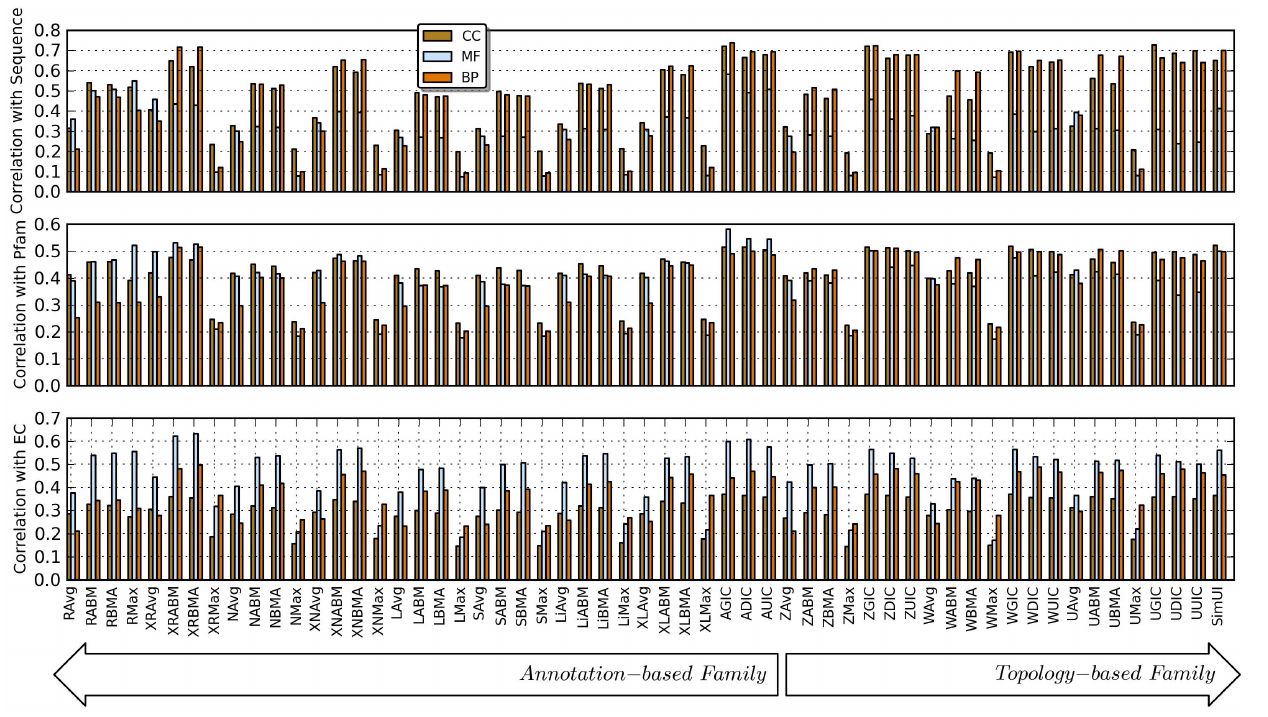
Figure 1. Performance evaluation in terms of Pearson’s correlation values. These different Pearson’s correlation values with Enzyme Commission (EC), Pfam and Sequence similarity are obtained from the CESSM online tool. For x-axis labels, the prefixes R, N, L, Li, S, X, A, Z, W, and U represent the approaches and stand for Resnik, Nunivers, Lin, Li, Relevance, XGraSM, Annotation-based, Zhang, Wang and GO-universal, respectively. The suffixes GIC, UIC and DIC represent SimGIC, SimUIC and SimDIC measures, respectively. In cases where the prefix X is used, it is immediately followed by the approach prefix. Refer to Table 2 and 3 for the description of these different